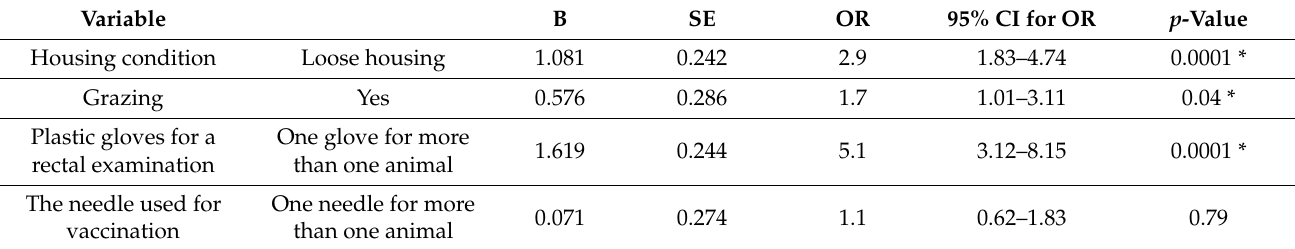
Table 2. Multivariant logistic regression analysis for associated risk factors to BLV